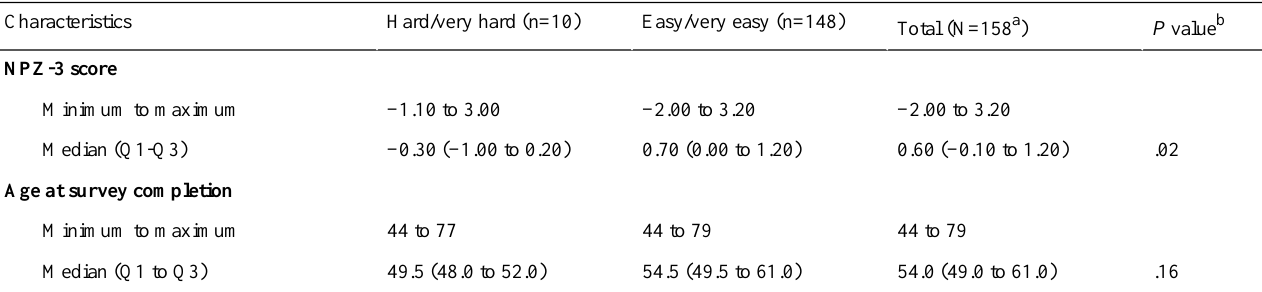
Table 4. Age and NPZ-3 score by